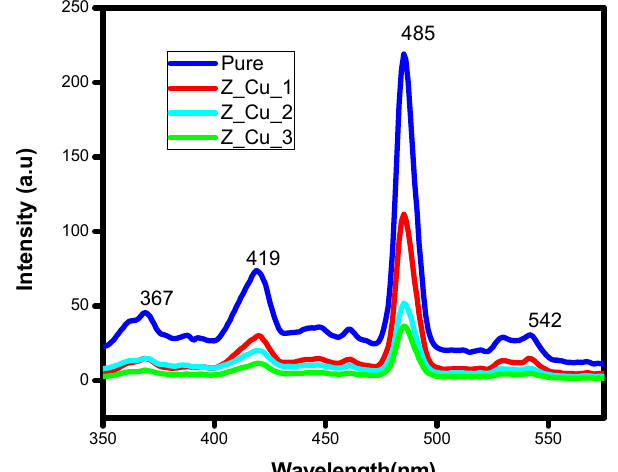
Fig. 6. PL spectra of pure and Cu doped ZrO